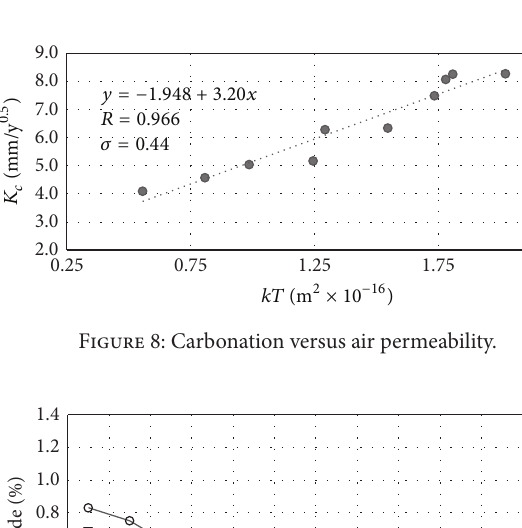
Figure 12: Chloride diffusion versus sorptivity.